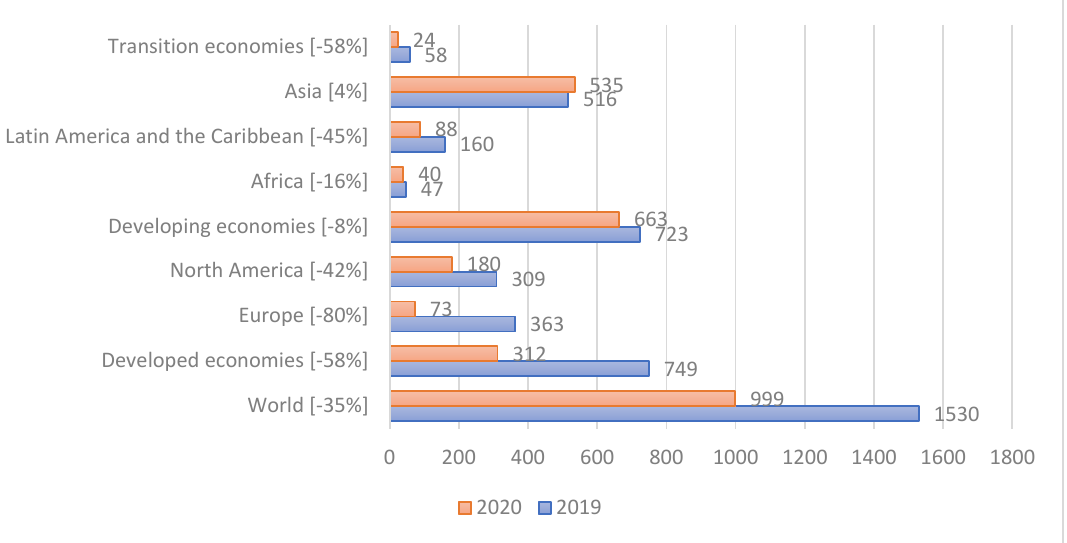
Figure 1. FDI inflows by region, 2019 and 2020 (billions of dollars and percentages). Source: